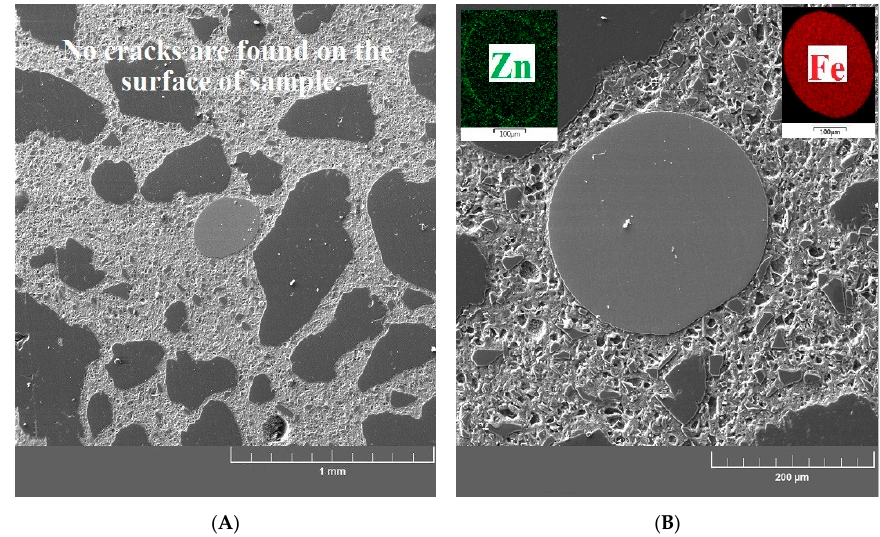
Figure 16. ( A ) SEM image of a sample after exposure to 200 °C focused on the UHPC matrix/aggregate interfacial transition zone. ( B ) SEM image of a sample after exposure to 200 °C focused on the brass-coated steel fiber/UHPC matrix interfacial transition zone.